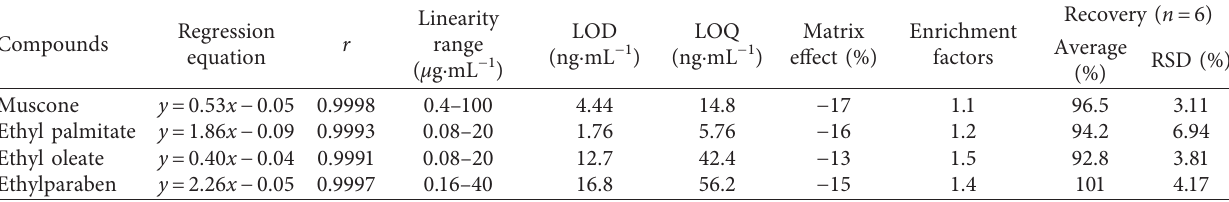
Table 2: The related results of method validation for the target compounds by the vortex assisted MSPD.